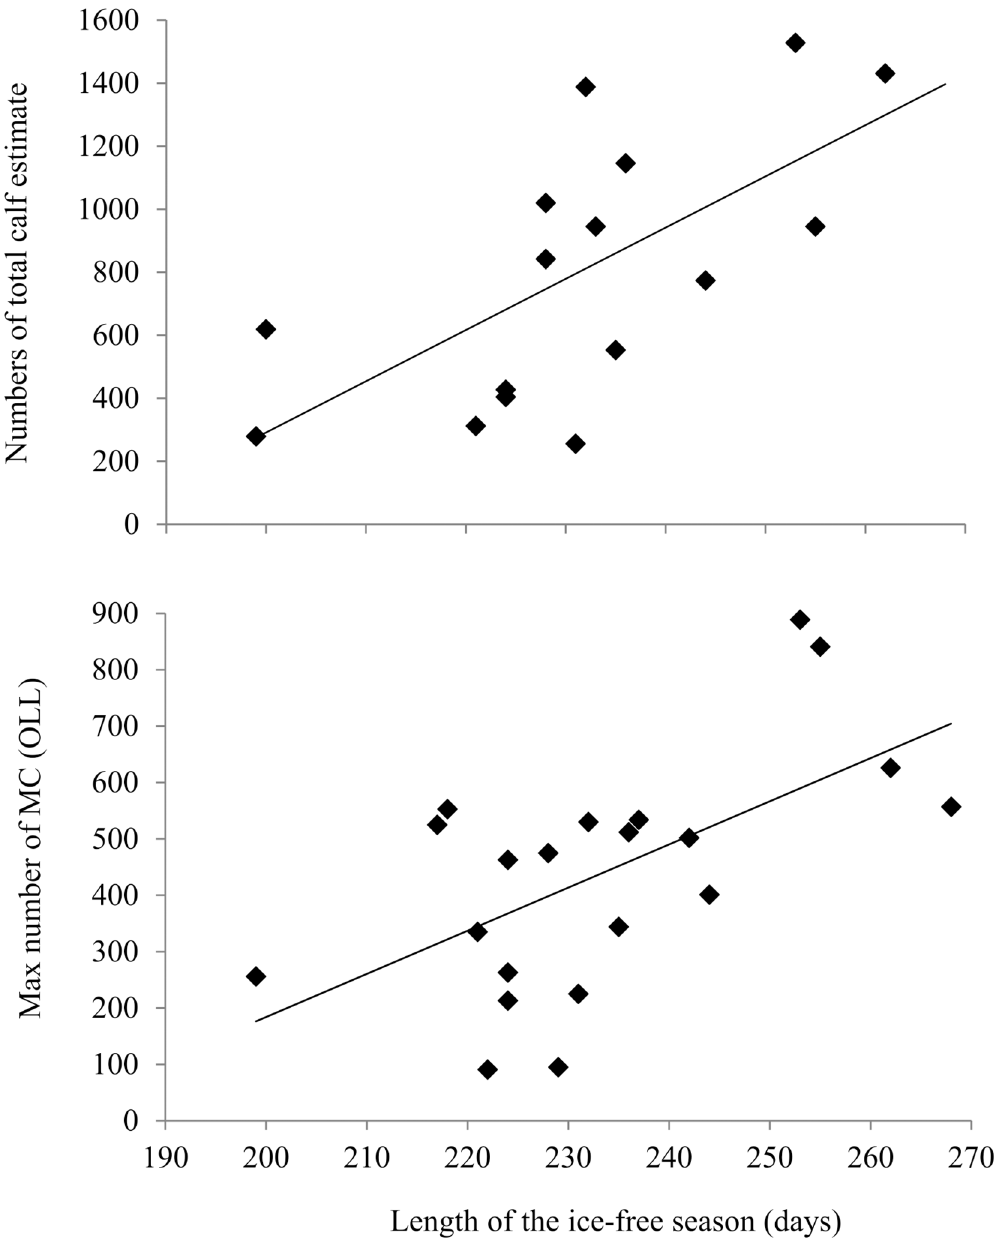
Fig 6. Mother-calf pairs vs previous summer conditions at the Bering sea: Upper panel. Total calf estimate from Piedras Blancas nearshore surveys vs length of the ice-free season of the previous feeding season at the Bering Sea; lower panel: maximum counts of mother-calf pairs (MC) at Ojo de Liebre Lagoon (OLL) during the month of February vs length of the ice-free season of the previous feeding season at the Bering